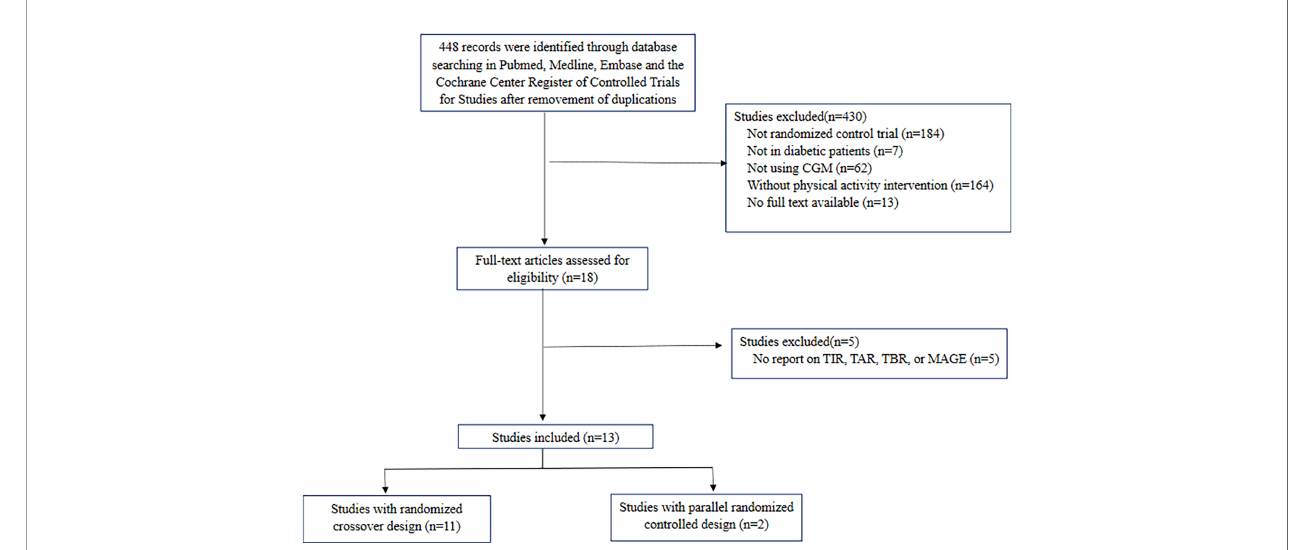
FIGURE 1 | Flow chart of included trials. CGM, continuous glucose monitoring; TIR, time in range; TAR, time above range; TBR, time below range; MAGE, mean amplitude of glycemic